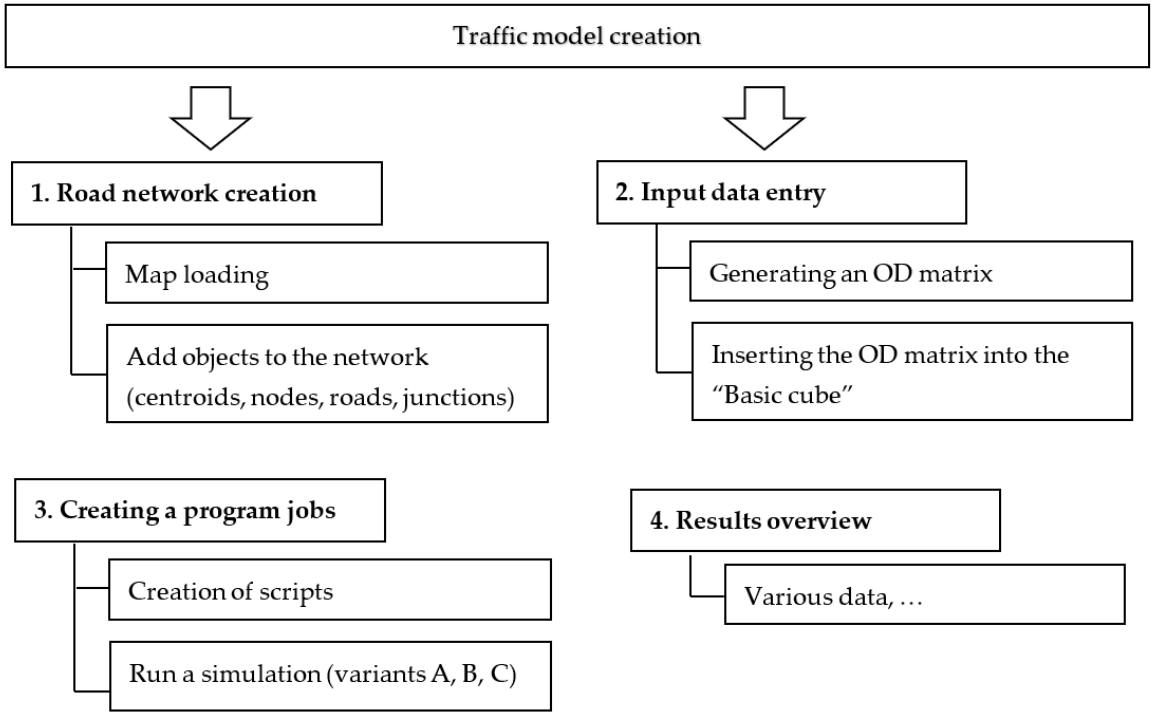
Figure 5. Scheme of traffic model creation, (source elaborated by authors).